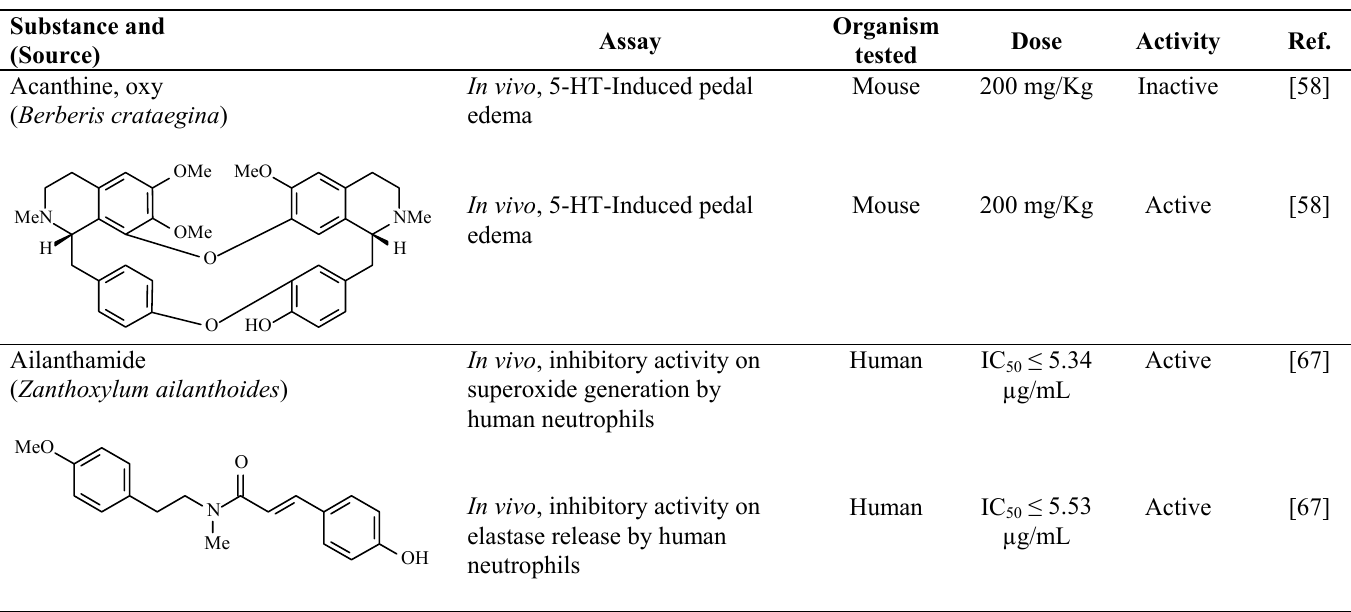
Table 1. Alkaloids with anti-inflammatory